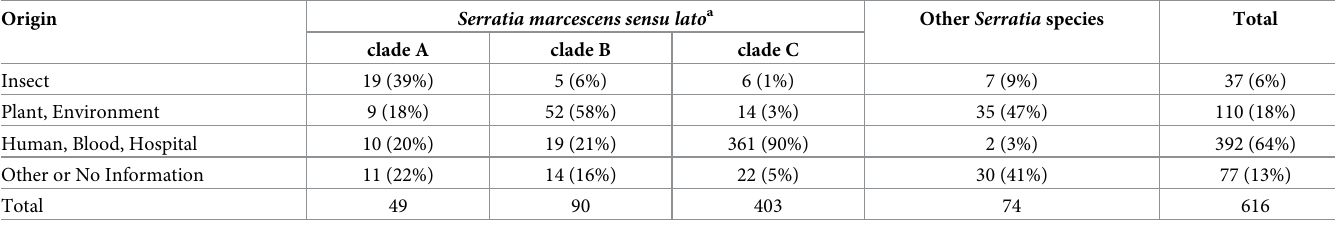
Table 2. Origin of isolates across different phylogenetic groups of Serratia spp. defined by the multiple alignment analysis of 14 housekeeping genes.